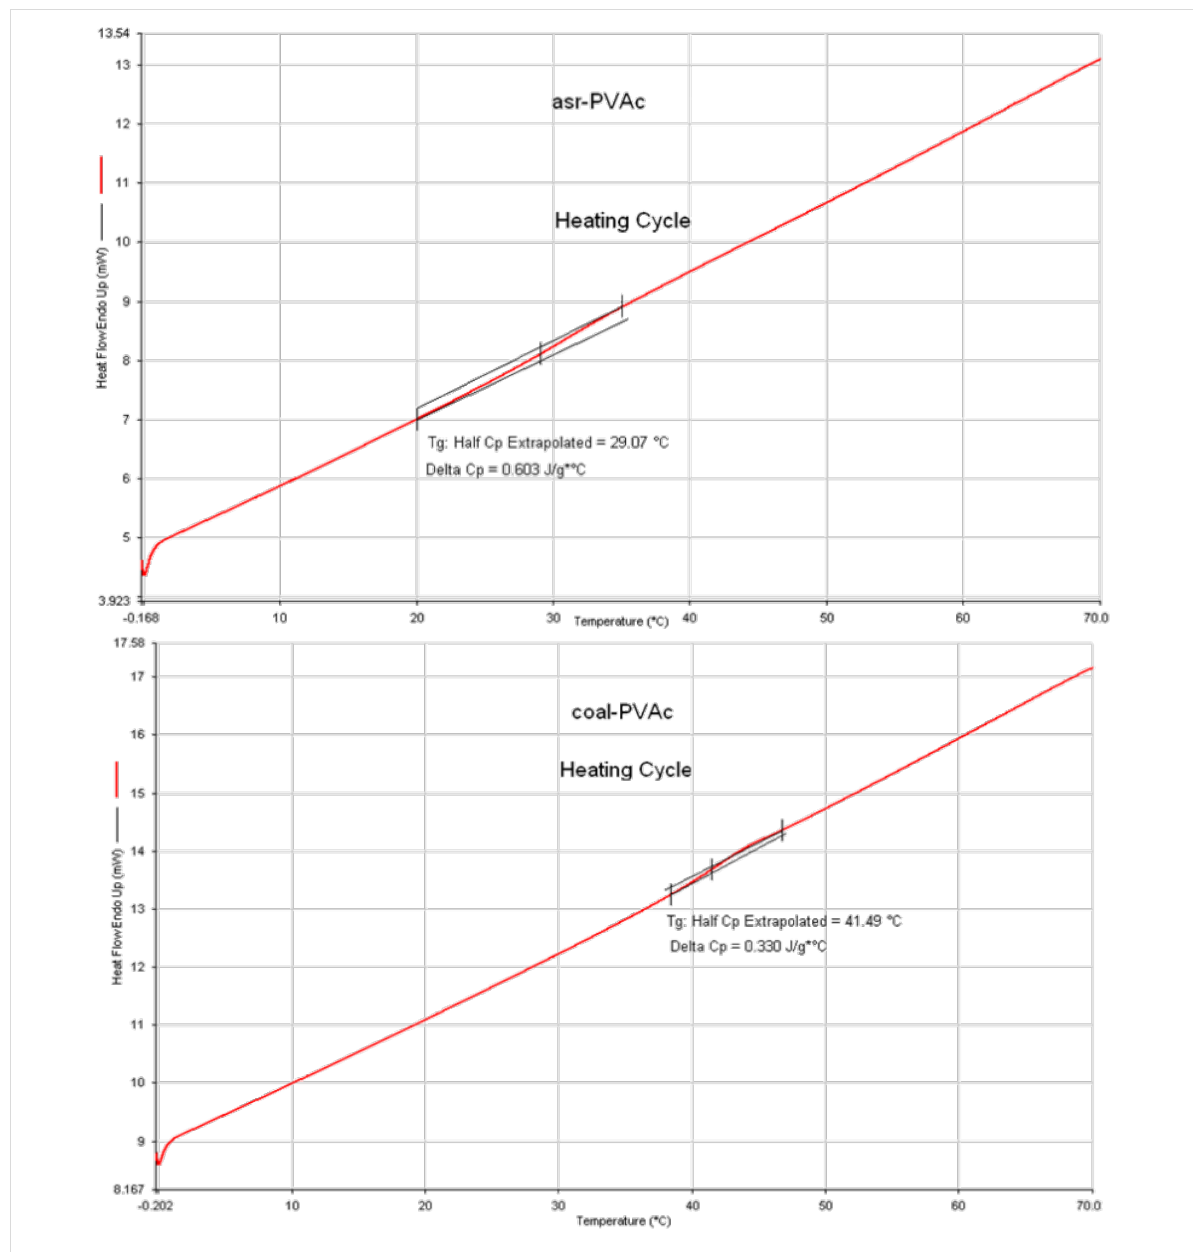
Figure 4: DSC heating scans for asr-PVAc (upper) and c-PVAc coalesced from its γ -CD IC (lower) [72].